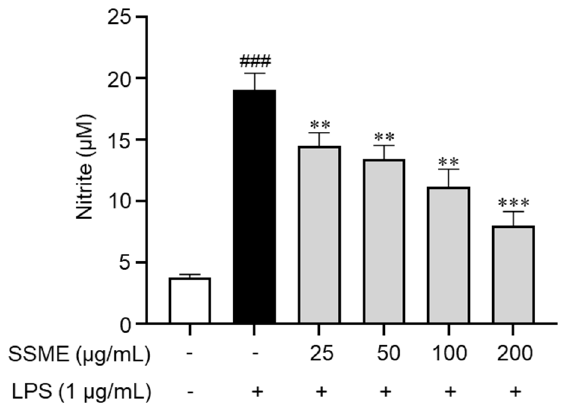
stimulation with LPS (1 μ g/mL) for 24 h. The SSME cytotoxicity was measured using the LDH assay kit. The data presented are the mean ± SEM of three independent experiments. Differences between groups were analyzed using the Mann–Whitney U test. SSME, Symplocos sumuntia Buch.-Ham. ex D. Don. methanol extract; LPS, lipopolysaccharide; LDH, lactate dehydrogenase.